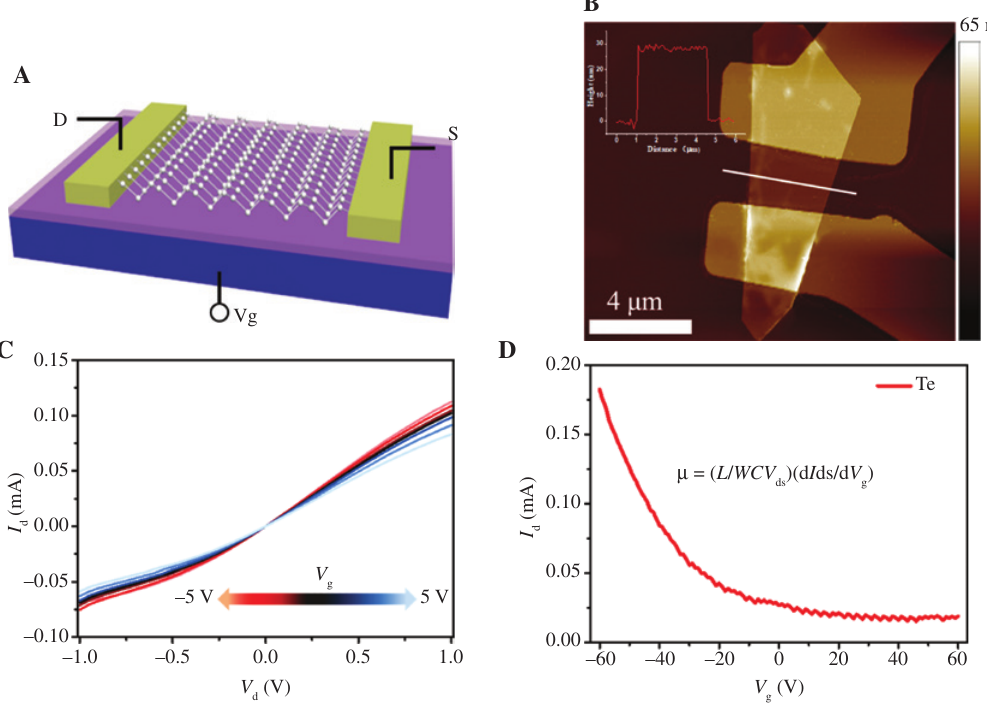
Figure 2: The structure and electronic characterization of the Te NS FET. (A) Schematic of the Te FET. (B) AFM image of the Te NSs photodetector (scale bar: 5 μ m). (C) I at various V from –5 to 5 V by applying a voltage on Si. (D) I g